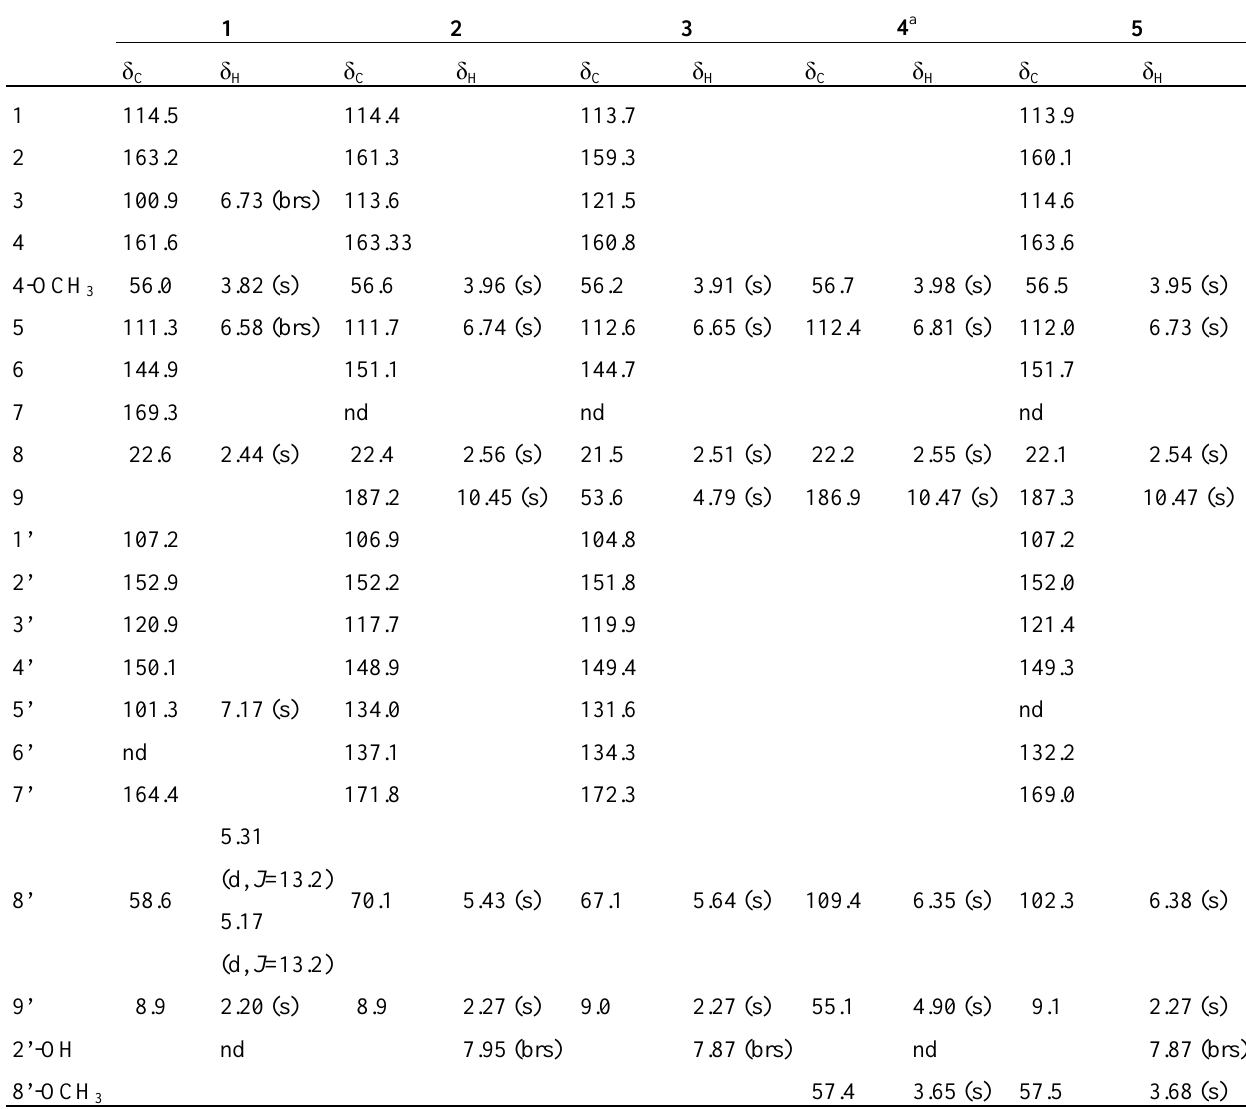
Table 1. 1 H- (400 MHz) and 13 C- (50.3 MHz) NMR spectral data of metabolites 1 , 2 , 3 and 5 in CDCl